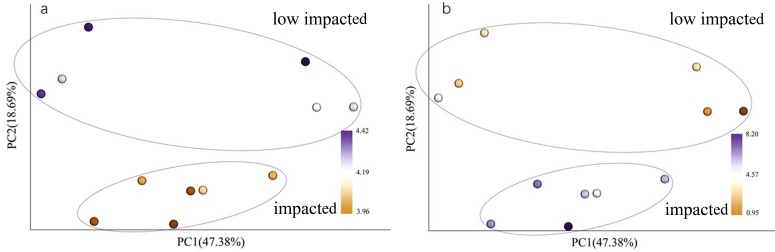
PCoA with color gradients mapped to (A) pH and (B) AP.Circles denote clusters defined as impacted and low impacted.